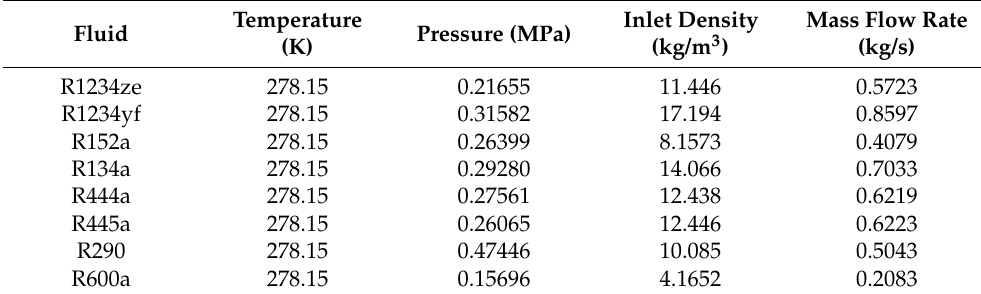
Table 4. Inlet Conditions for Working Fluids